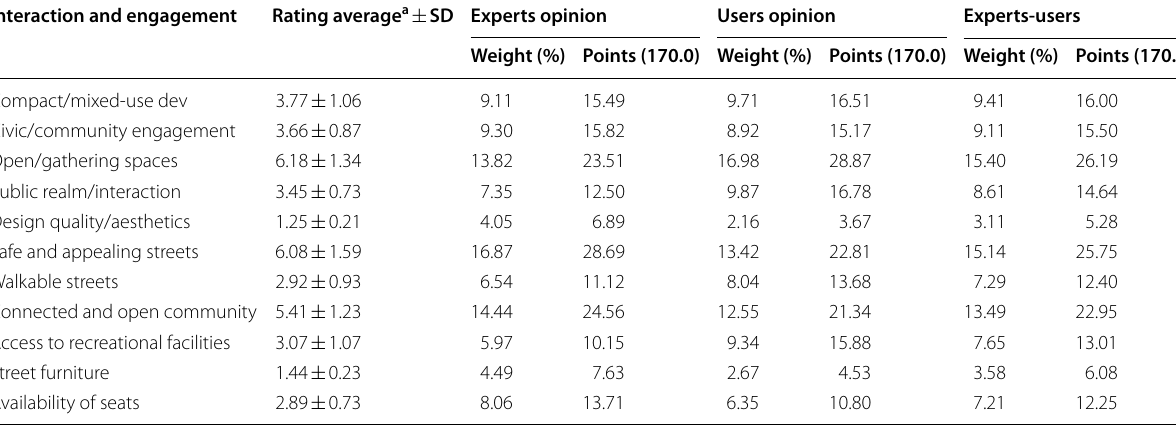
Table 4 Rating and weights of factors in the interaction and engagement